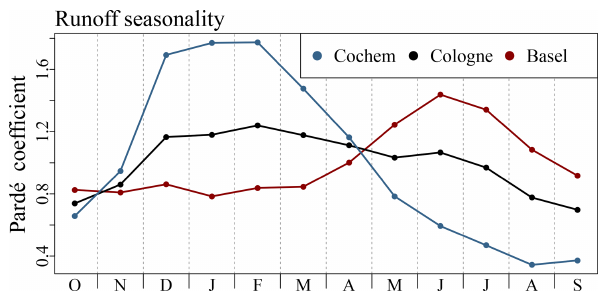
Figure 4. Pardé coefficients (ratio of average monthly discharge and the mean annual discharge) (Pardé, 1933; Spreafico and Weingart- ner, 2005) for the gauges at Cochem, Basel and Cologne calculated based on measured discharge from the time frame 1971 to